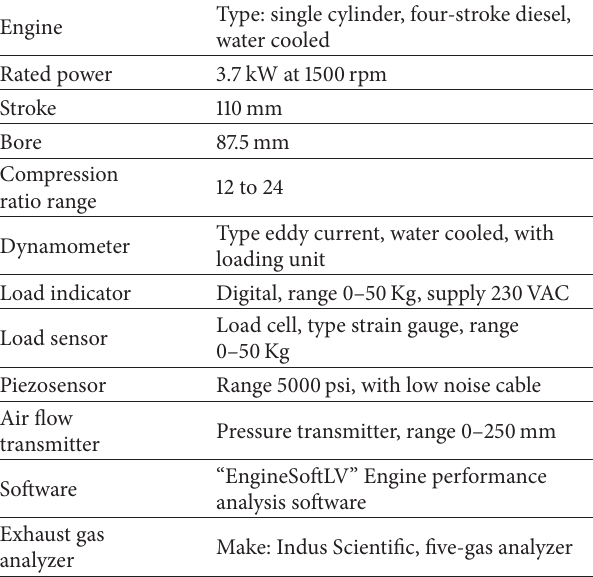
Table 3: Properties of base fuels.